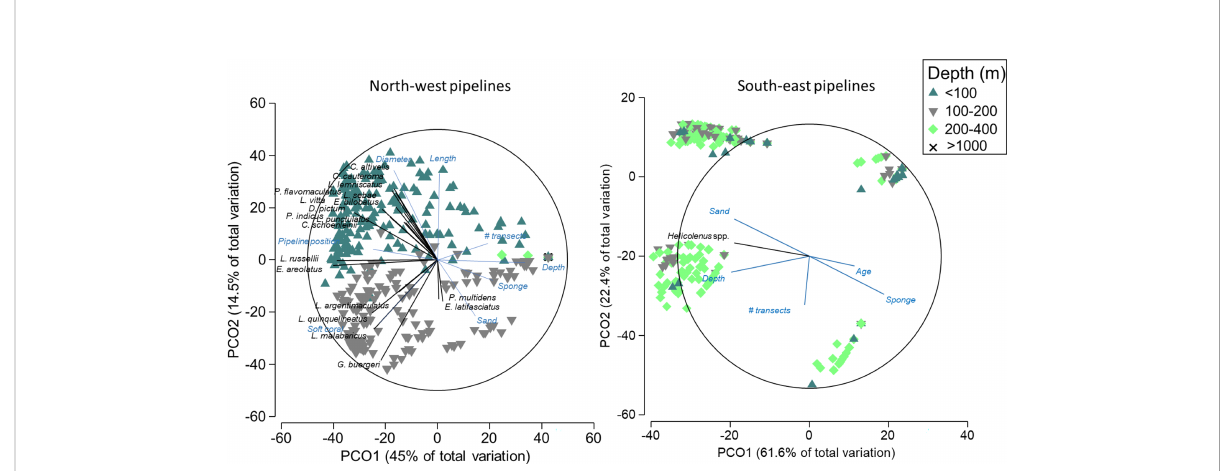
FIGURE 8 Principal component ordination (PCO) on fi shery target species abundance on pipelines in the north-west and south-east marine regions. Vectors are displayed and show fi sh species and explanatory variables with Pearson ’ s correlations of |R|>0.3 to one or more axes. Vectors indicate the direction of the relationship, and their length indicates the strength of their effect on the assemblage of fi shery target